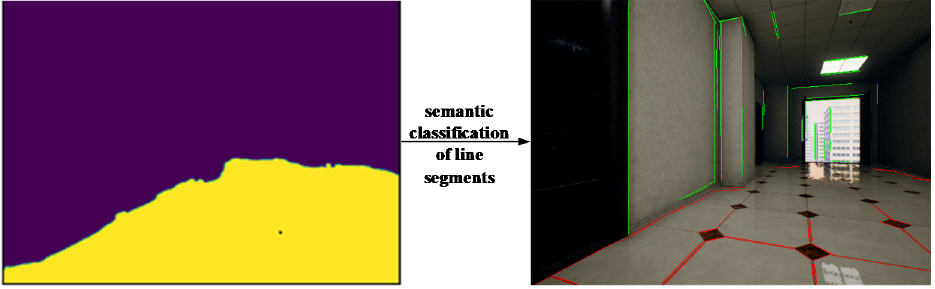
Figure 5. Line segment classification.